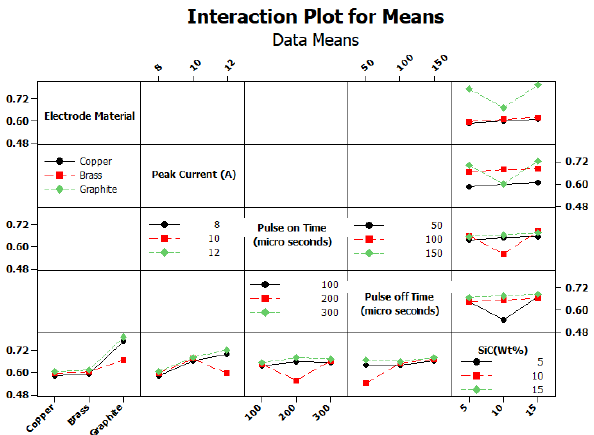
Figure 29. Interaction plot of EWR (mm 3 /min) under different machining conditions. J. Compos. Sci. 2022 , 6 , x FOR PEER REVIEW